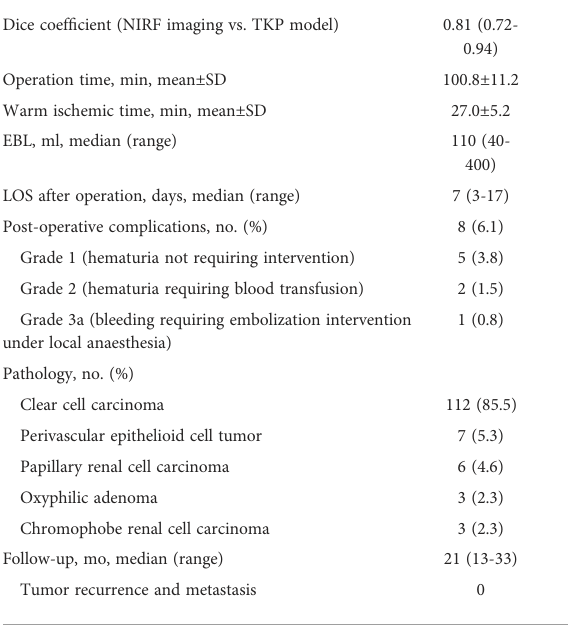
TABLE 2 Perioperative outcomes and